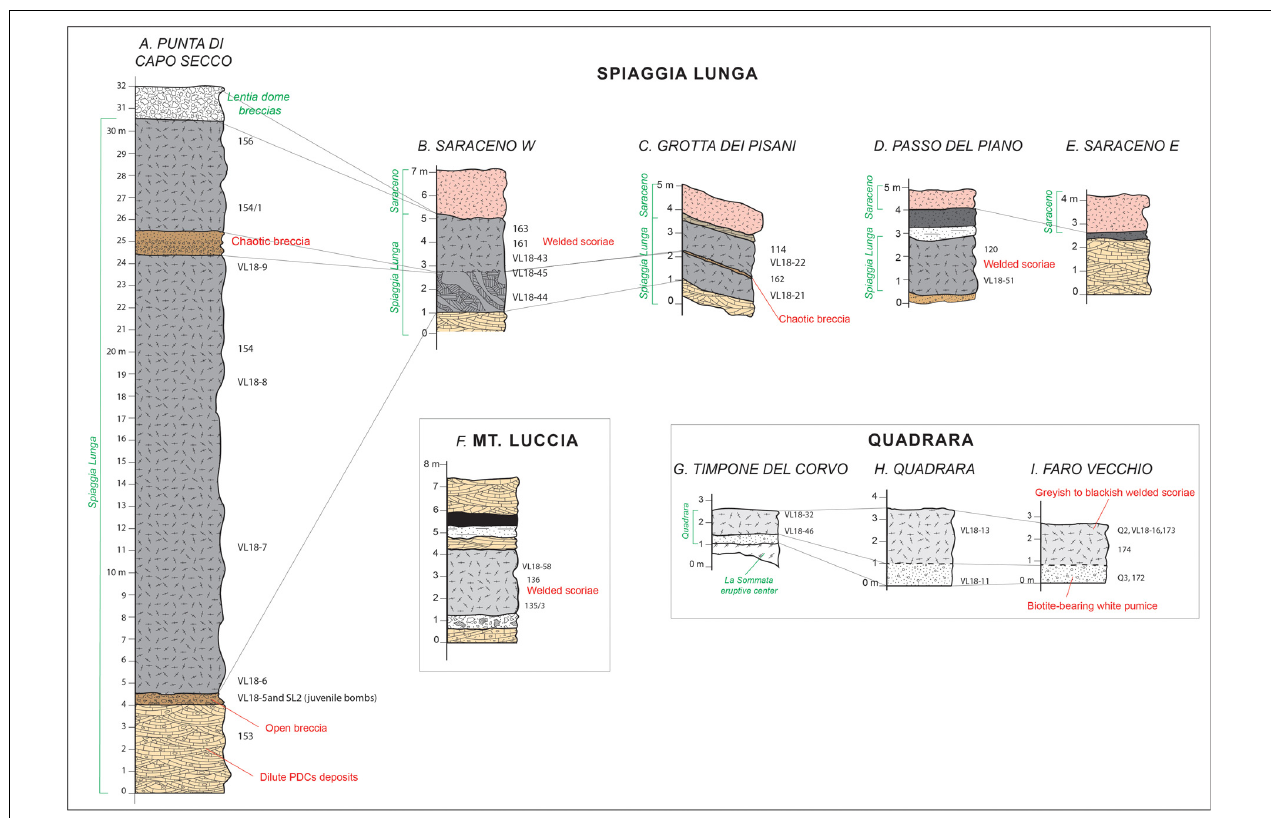
FIGURE 5 | Stratigraphic successions of the studied eruptive events. The location of each column is indicated by the capital white letter in the black box of Figure 1